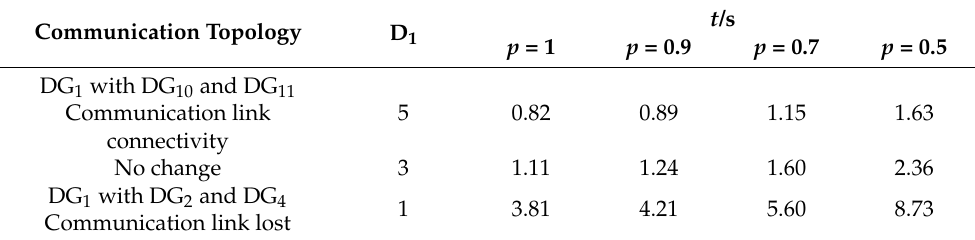
Table 3. Convergence times for different leader connectivity links and p